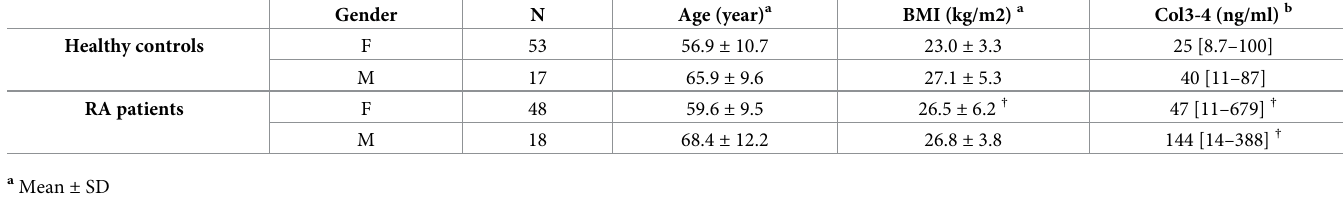
Table 3. Demographical data and serum Col 3–4 levels in healthy controls and in patients with RA by